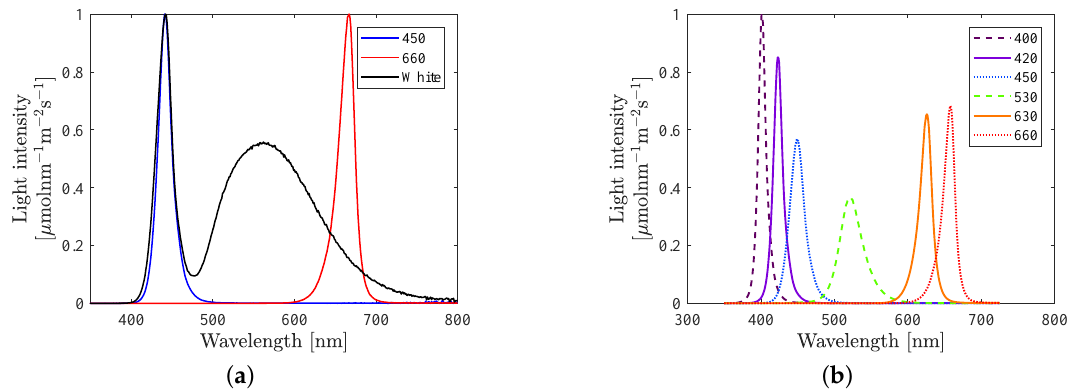
Figure 1. ( a ) Spectrum from the LX lamp for the blue, white and red LEDs, used to generate background light. ( b ) Spectrum from the RX lamp for each of the six LEDs used to generate excitation